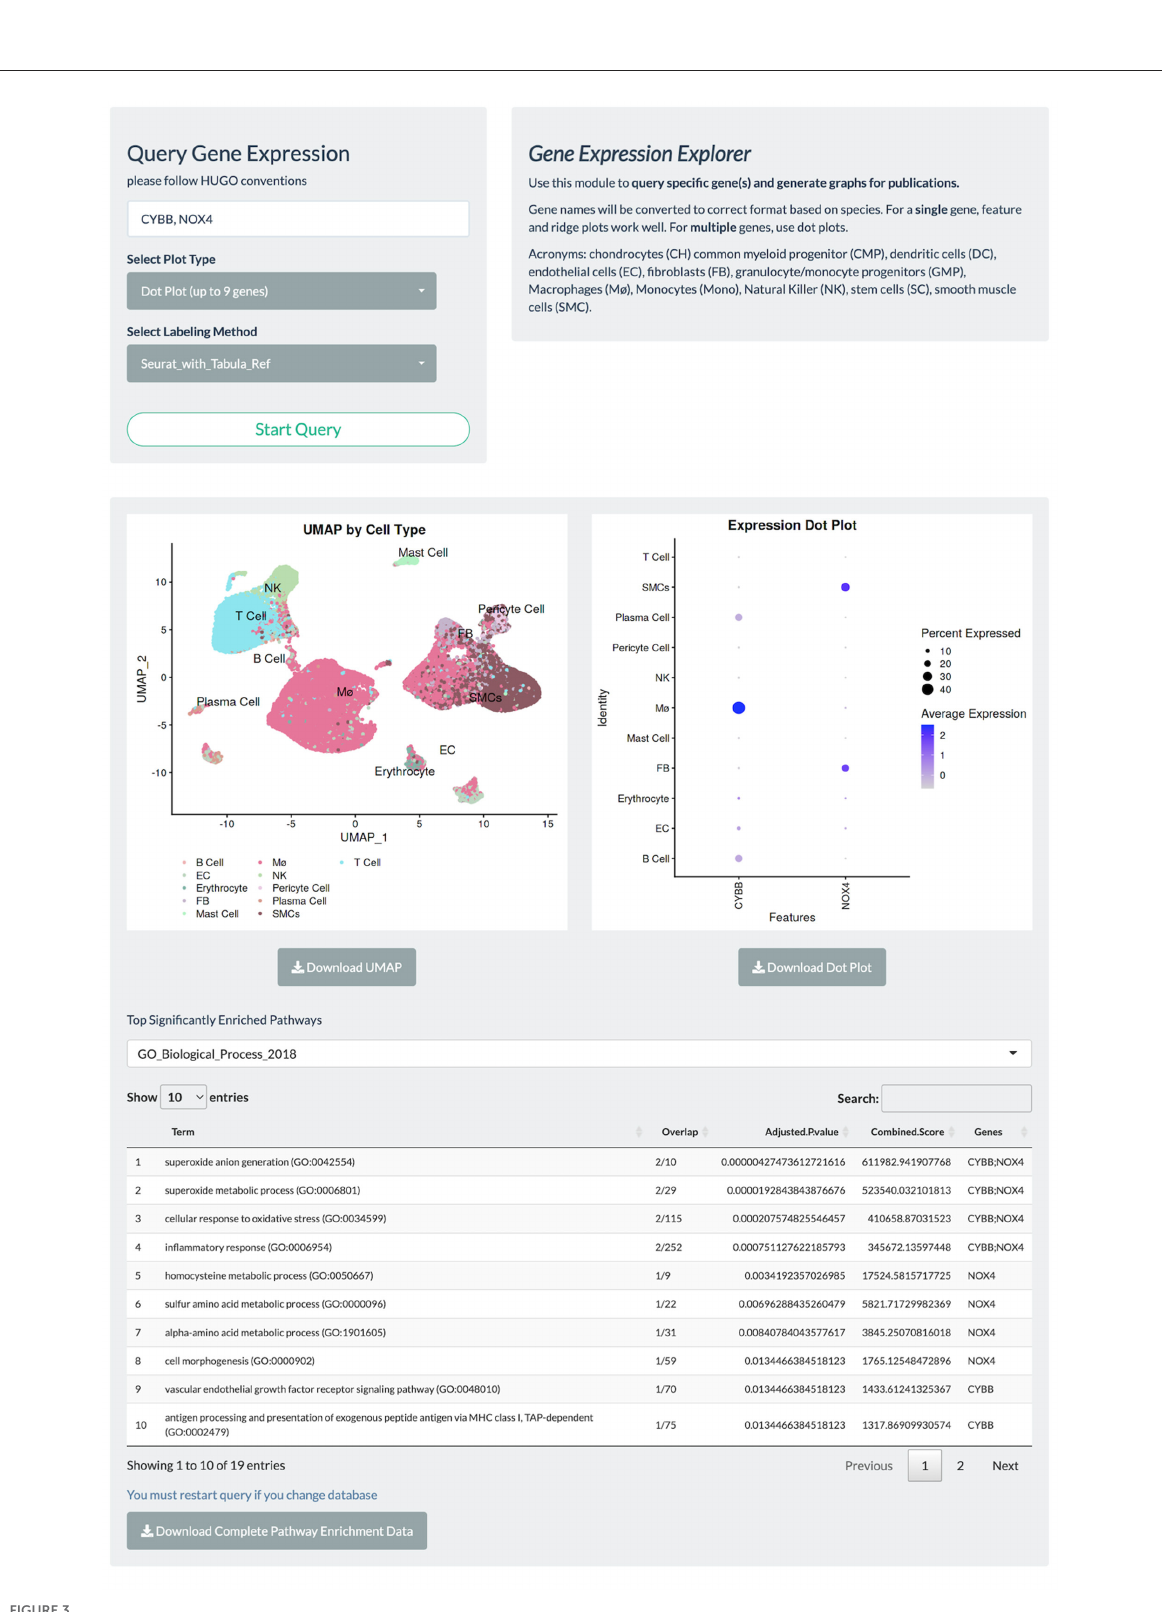
FIGURE3 Gene query page allows rapid visualization of gene expression, UMAP embeddings, and facilitates automated GSEA. PlaqView 2.0 supports visualization of a single gene or multiple genes via feature, dot, and ridge plots, as powered by Seurat. Users can also choose their preferred annotation methods and download high-quality pdfs for publication. This instance is a demonstration using the Li et al.